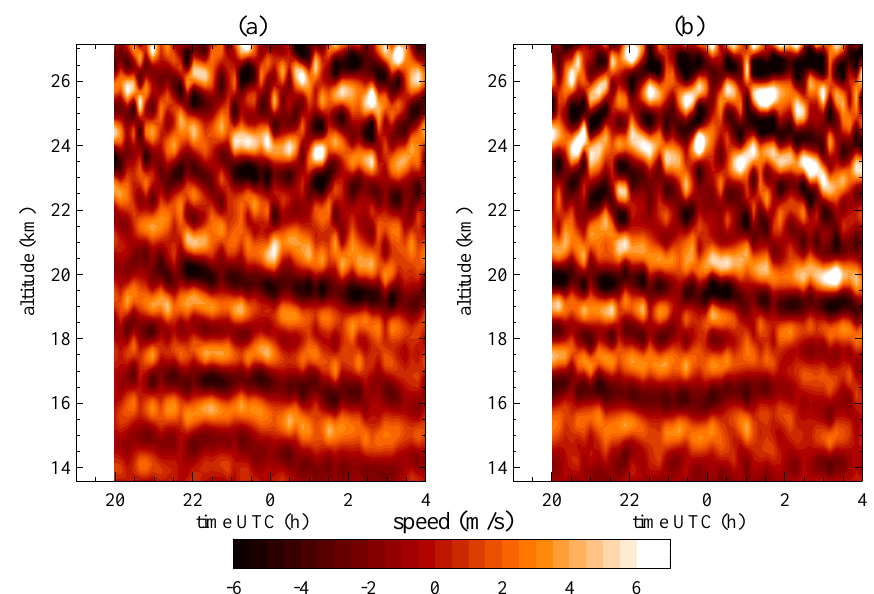
Fig. 2. Time-altitude plot of the zonal (a) and meridional (b) components of the horizontal-wind velocity measured by the Doppler lidar at OHP on 3 September